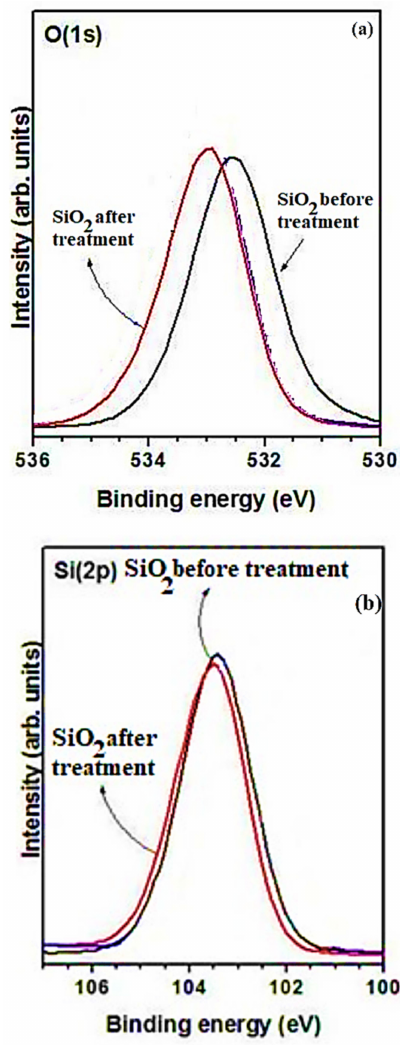
Figure 8. XPS spectra of SiO 2 before and after treatment ( a ) O1s, ( b )